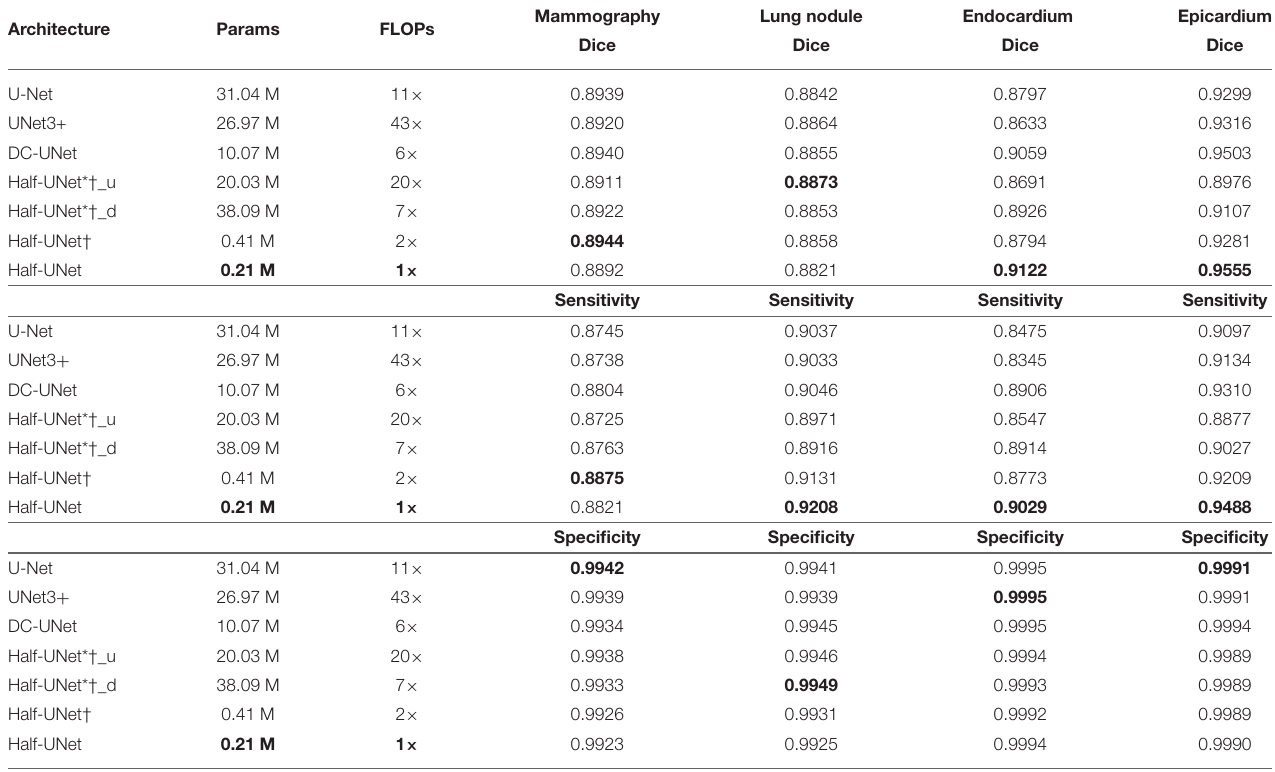
TABLE 3 | Comparison of U-Net and its variants and the proposed Half-UNet on three datasets.